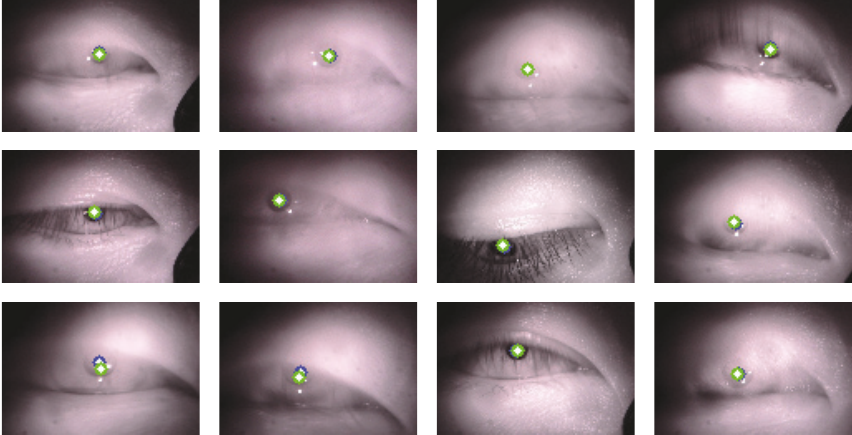
Figure 9: Success samples of medium eye image.